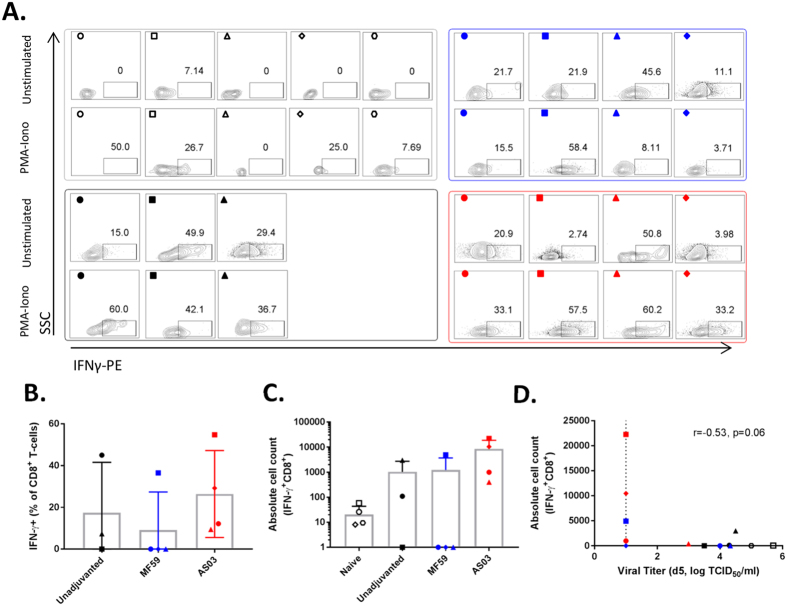
Levels of activated CD8+ T-cells in the bronchoalveolar lavage fluid (BALF). (A) Flow plots showing the percentage of IFN-γ+ cells within the CD8+ population for unstimulated and PMA/Ionomycin stimulated cells for each ferret as indicated in Fig. 1. The percentage in unstimulated were subtracted from the PMA/Ionomycin stimulated cells for each individual ferret to obtain the values shown in (B) and (C). Negative values are set at 0. (B) Normalized percentage and (C) absolute cell numbers of CD8+ IFN-γ+ T-cells after ex vivo stimulation of cells with the PMA/ionomycin mitogen cocktail. All data are presented as group means and error bars represent ±standard deviation. Correlation between (D) the absolute numbers of CD8+ IFN-γ+ T-cells with day 5 viral titers in the nasal wash. Correlation is determined using Pearson’s correlation coefficient, (r) with the p-value as indicated. Dashed line indicates limit of detection (LOD) of the virus titration assay. Ferrets with undetectable (negative) CD8+ IFN-γ+ activity were arbitrarily set at 1 cells/ml. Individual ferrets are assigned its respective symbol within its vaccine group (colored as ○ for naïve, ● for unadjuvanted,  for MF59 and  for AS03).